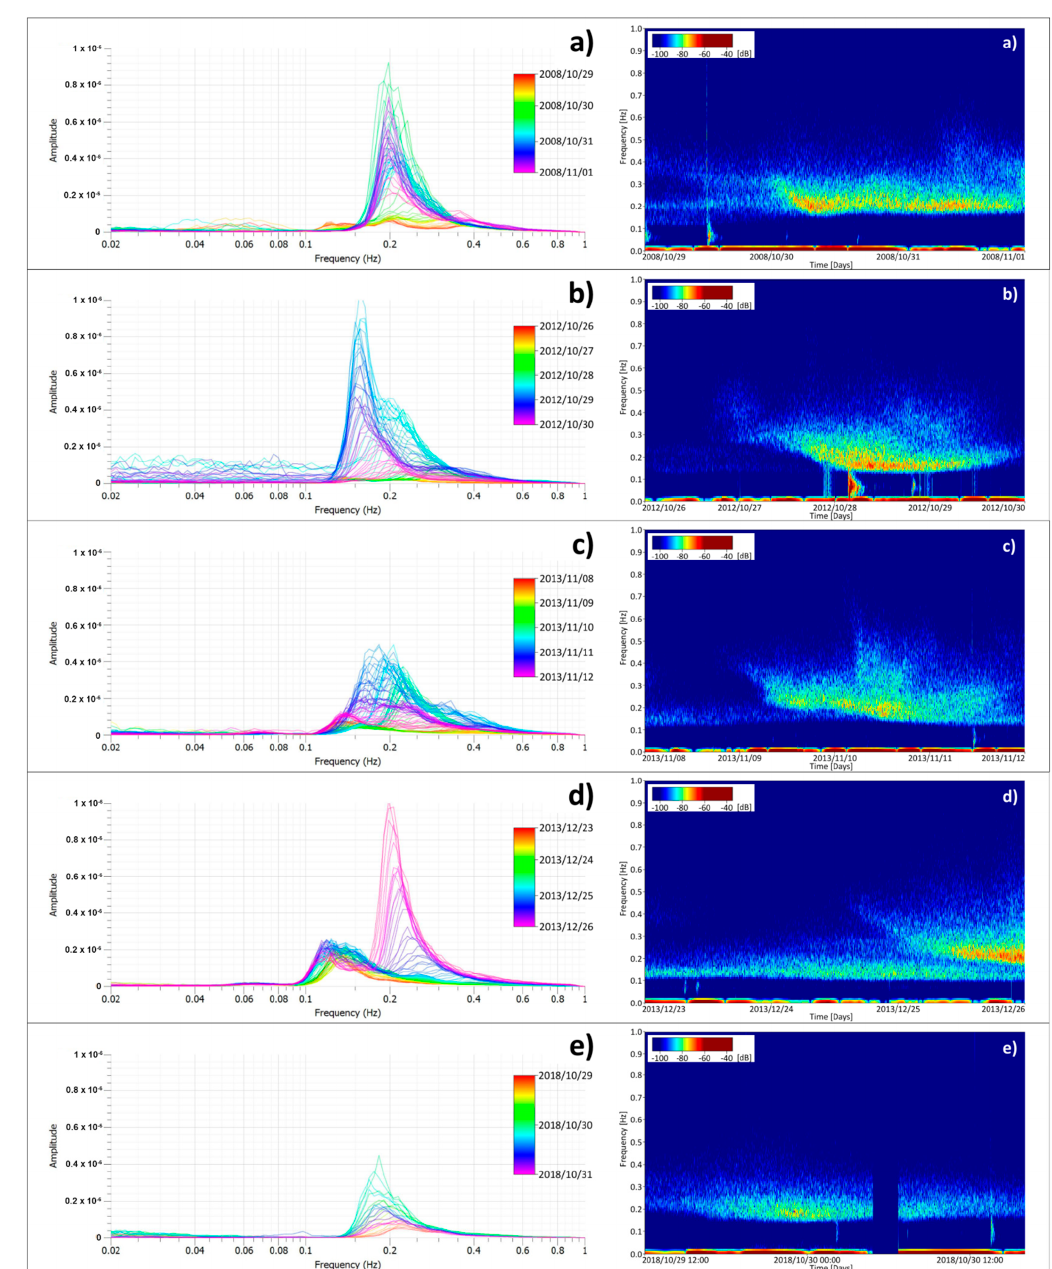
Figure 4. Fourier amplitude spectra (normalised to the duration of the signal) for all one-hour windows in which each microseism recording was divided (on the left) and spectrogram of the vertical component of the microseism recorded during the five sea storms under study (on the right). ( a ) October 2008; ( b ) October 2012; ( c ) November 2013; ( d ) December 2013; ( e ) October 2018. The time window considered is not the same for all sea storm due to lack of data.